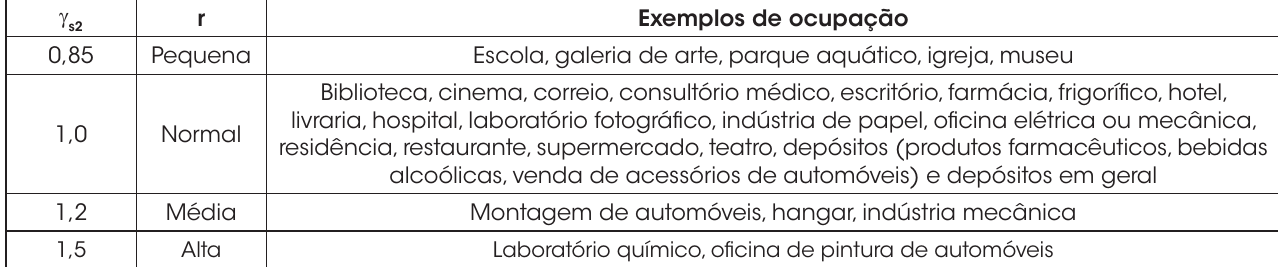
Valores de γ em função do risco (r) de ativação do incêndio (ABNT NBR 15200:2012; IT8, s2